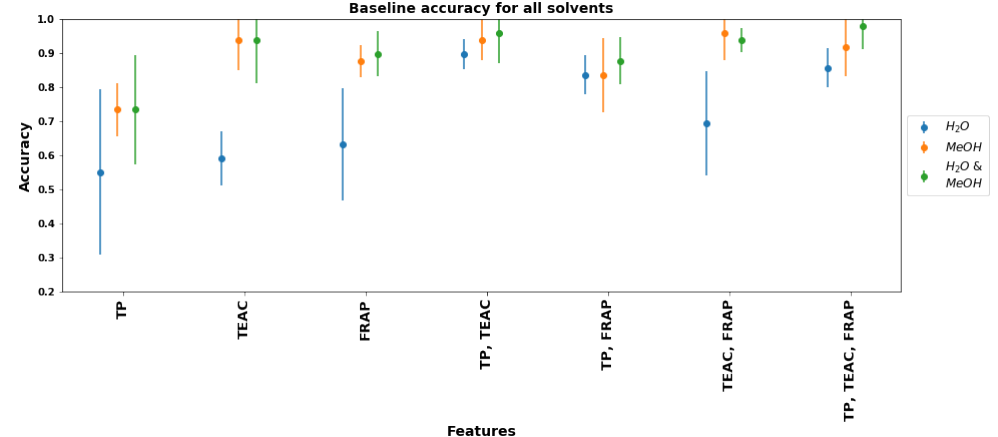
Figure 11. Accuracies of baseline classifiers for FR and UFR based on seven different feature sets using extraction data from water only, methanol only, and both water and methanol. Error bars show two standard